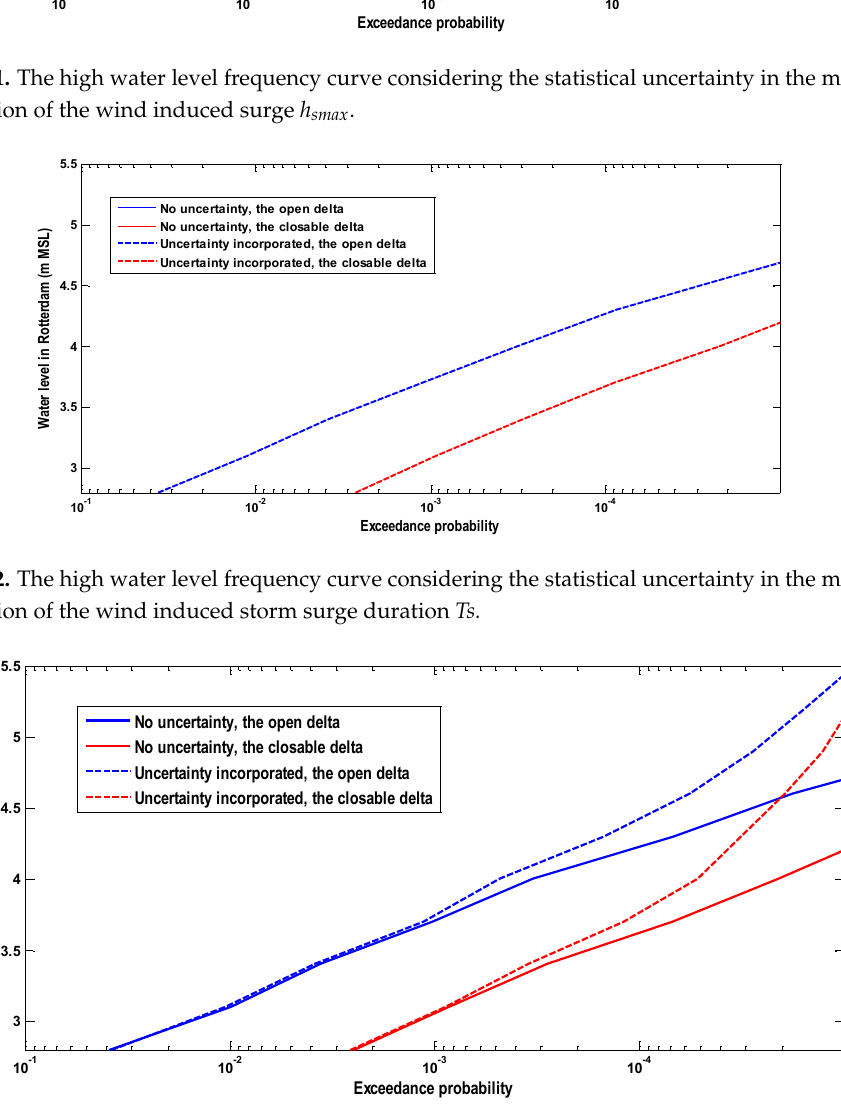
Figure 13. The high water level frequency considering the statistical uncertainty in the above two marginal distributions.